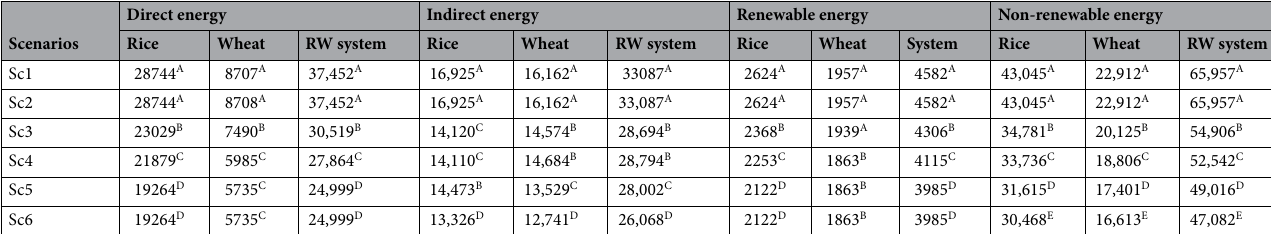
Table 2. Total energy input (MJ ha −1 ) in the form of direct, indirect, renewable and non-renewable energy for different management practices under the rice, wheat and RW system. Values with different upper case (A–E) letters are significantly different between each scenarios at p < 0.05 (Duncan multiple range tests for separation of mean). Sc1, business as usual-conventional tillage (CT) without residue; Sc2, CT with residue; Sc3, reduce tillage (RT) with residue + recommended dose of fertilizer (RDF); Sc4, RT/Zero tillage (ZT)